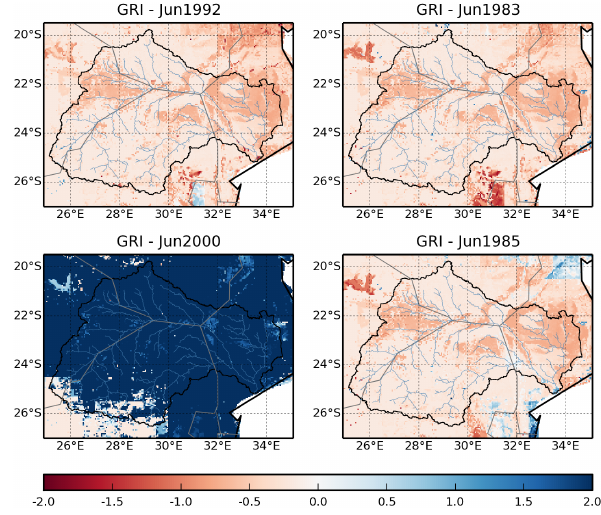
Figure 5. Groundwater Resource Index (GRI) for selected